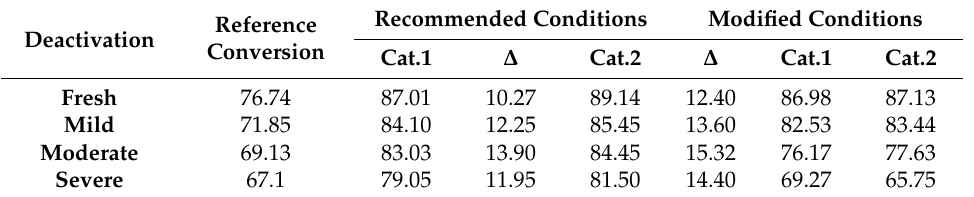
Table 4. Catalytic activity (wt. %) under different hydrothermal